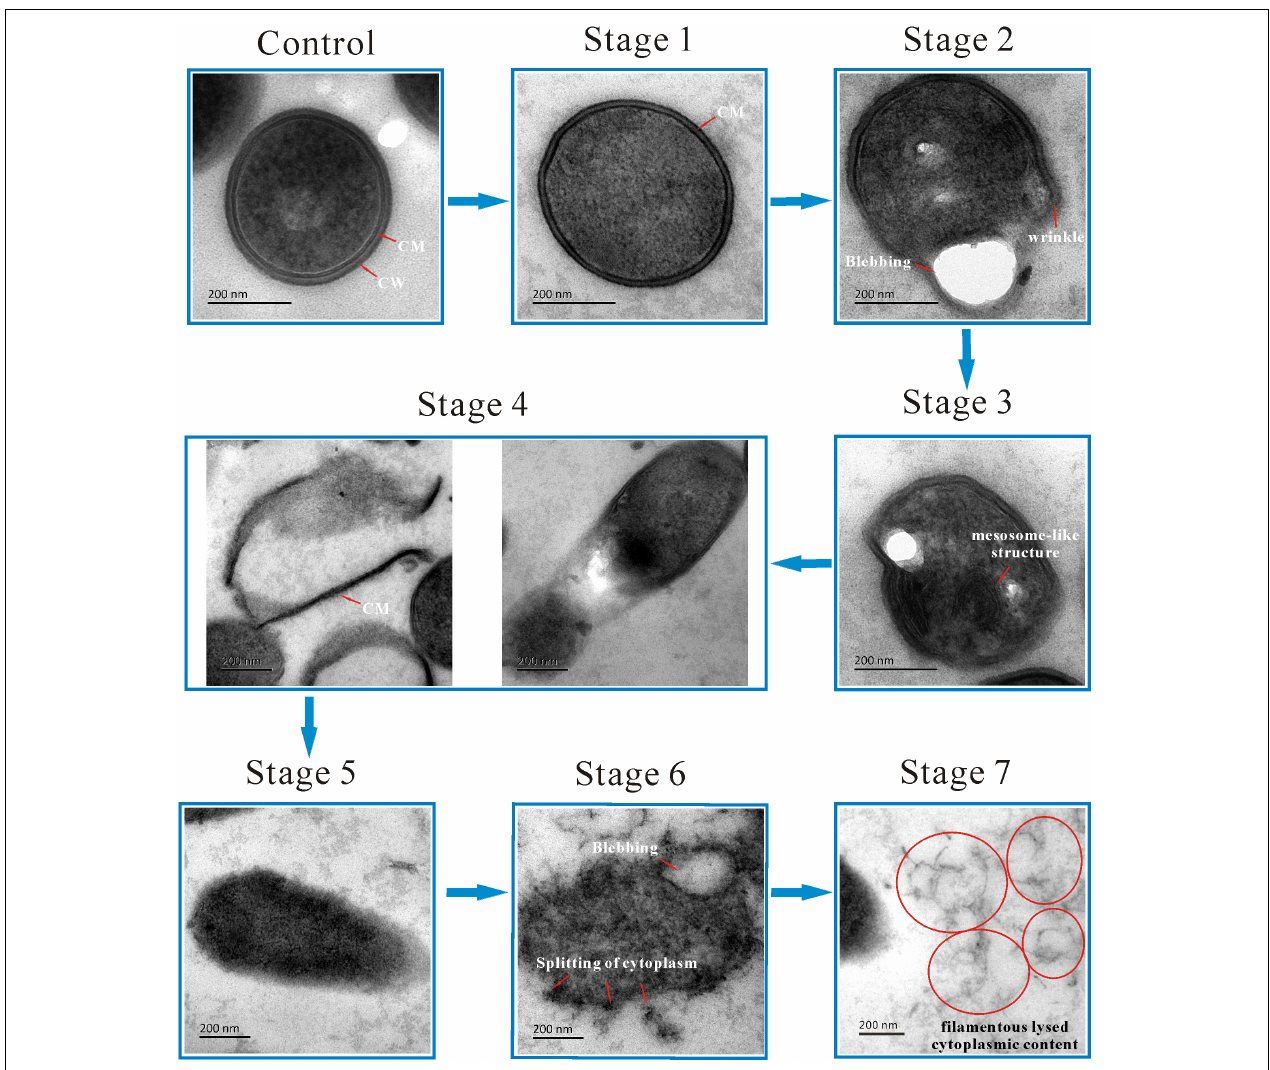
FIGURE 2 | TEM micrograph showing the morphological changing process of L. monocytogenes planktonic cell after treated with linalool. (Control) untreated bacteria; (Stage 1–7) bacteria treated with linalool. The red arrows and circles (together with white characters beside them) indicated the structure or the morphological changes of cells. CM and CW represented cytoplasmic membrane and cell wall